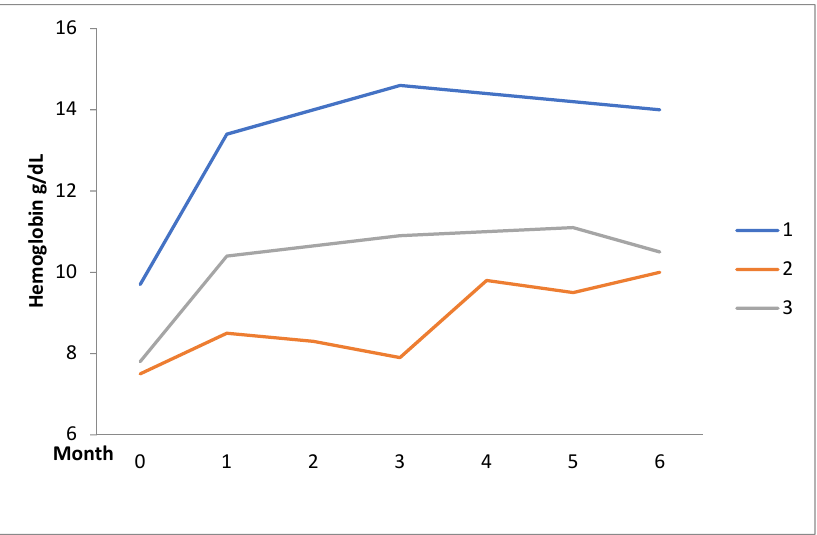
Figure 1. Serial changes in hemoglobin levels over time in autoimmune hemolytic anemia after initiation of danazol.